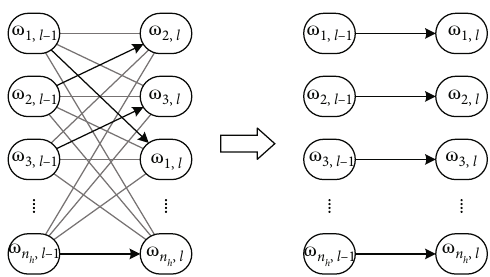
Figure 3: Illustration of the modal matching and alignment procedure. Gray lines: distance metrics between each adjacent mode. Black arrow lines: mode pairing with minimum total